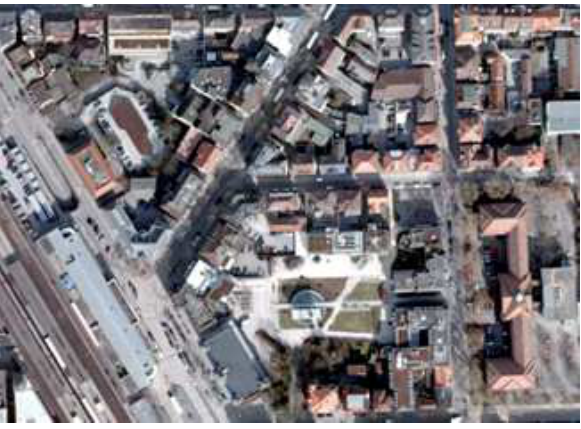
Figure 2: Original RGB-orthophoto